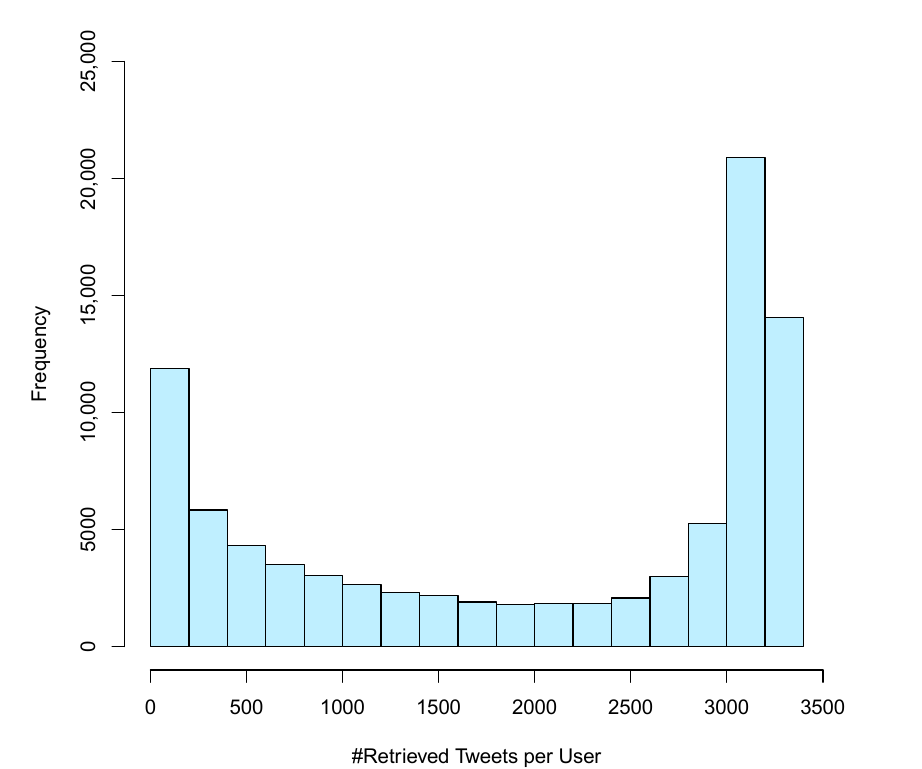
Figure 4. Distribution of the number of retrieved tweets per user. Table 3. GUs vs. NGUs based on profile